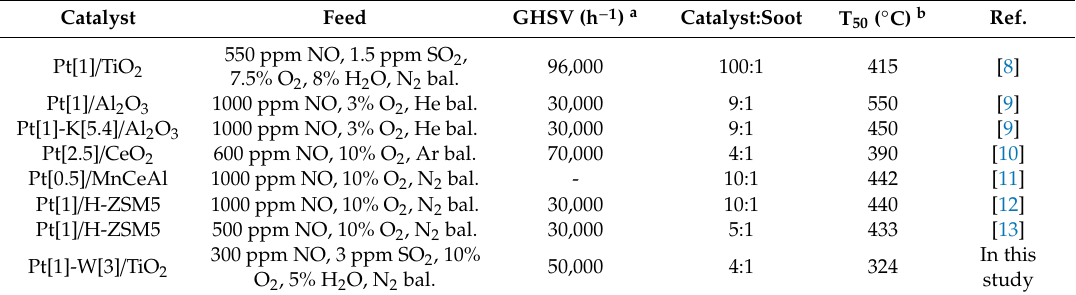
Table 1. Comparison of the activities of various platinum catalysts for soot